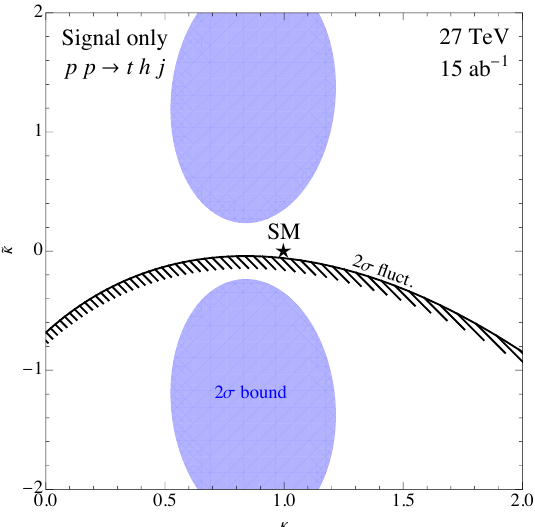
Figure 5 . Bounds in the ( (cid:20); ~ (cid:20) ) plane using the optimized observable O opt for the single-top associated production with a Higgs boson. The blue shaded region corresponds to the 2 (cid:27) ( (cid:31) 2 > 6 : 18) exclusion zone assuming the measurement of the SM at the HE-LHC (15 ab (cid:0) 1 ). The black line and stripes shows the 2 (cid:27) excluded region for a 2 (cid:27) positive (cid:13)uctuation at the HE-LHC (see text for